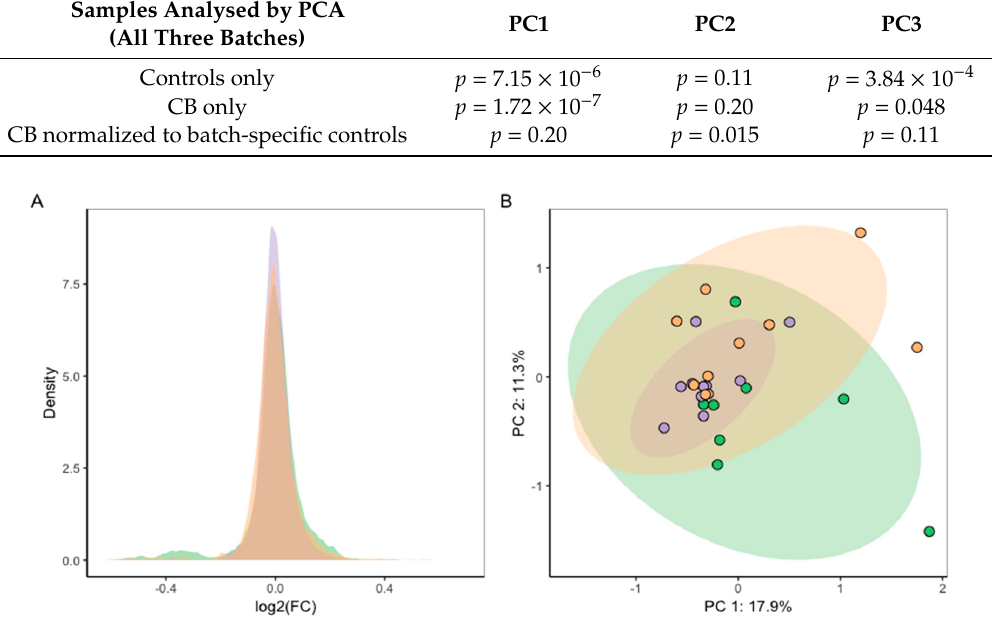
Figure 7. To increase comparability of exposure effects over the three repeated experiments, m/z feature intensities in CB groups were normalised to their batch-respective control groups by calculating the log 2 fold-change of m/z features: ( A ) density distribution of LFC values for each batch (log 2 (median[Int CB ]/median[Int Control ]), per m/z feature) ; ( B ) PCA scores plot from analysis of LFC values of all three batches (log 2 (Int CB /median[Int Control ]), for each m/z feature and for each of 10 CB